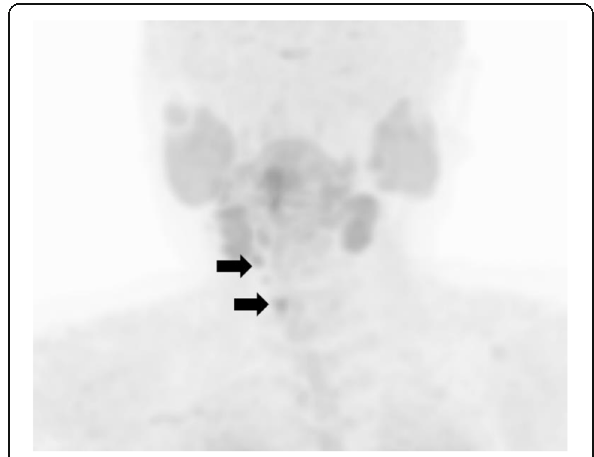
Fig. 7 11 C-methionine PET-CT findings after the removal of local recurrence. Methionine-positive tumors right next to the trachea